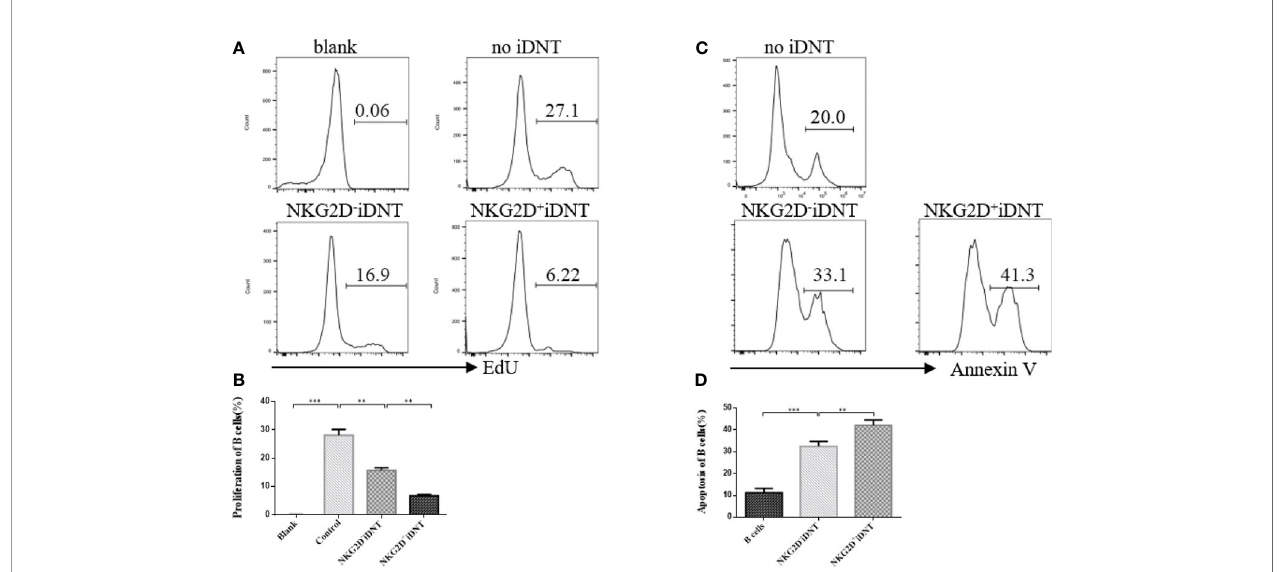
FIGURE 3 | NKG2D enhances iDNT cell-mediated inhibition of B cell proliferation and promotes B cell apoptosis. Naïve B cells were cultured with sorted TCR ab + CD3 + CD4 - CD8 - NKG2D + or TCR ab + CD3 + CD4 - CD8 - NKG2D - iDNT cells at a ratio of 4×10 5 B cells to 1×10 5 iDNT cells in 96-well round-bottom plates in B cell medium. EdU (10 m M) and LPS (5 m g/mL) were added to the medium, and B cell proliferation and apoptosis were detected approximately 18 hours later. (A) Histograms are representative of B cell proliferation. (B) The bar graphs are representative of three independent B-cell proliferation experiments. (C) Histograms are representative of B cell apoptosis. (D) The bar graphs are representative of three independent B-cell apoptosis experiments. Student ’ s t -test was used to compare two independent variables (**p < 0.01 and ***p <